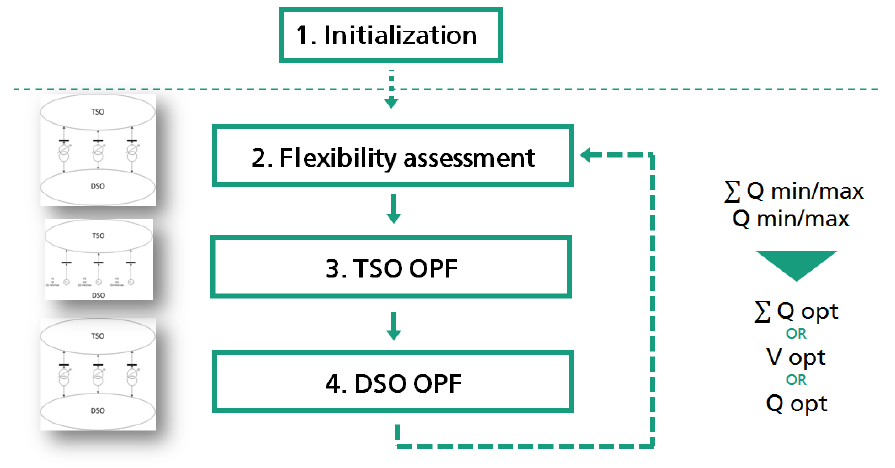
Figure 8. Scheme of the proposed coordinated voltage control method with grid models used in each step.